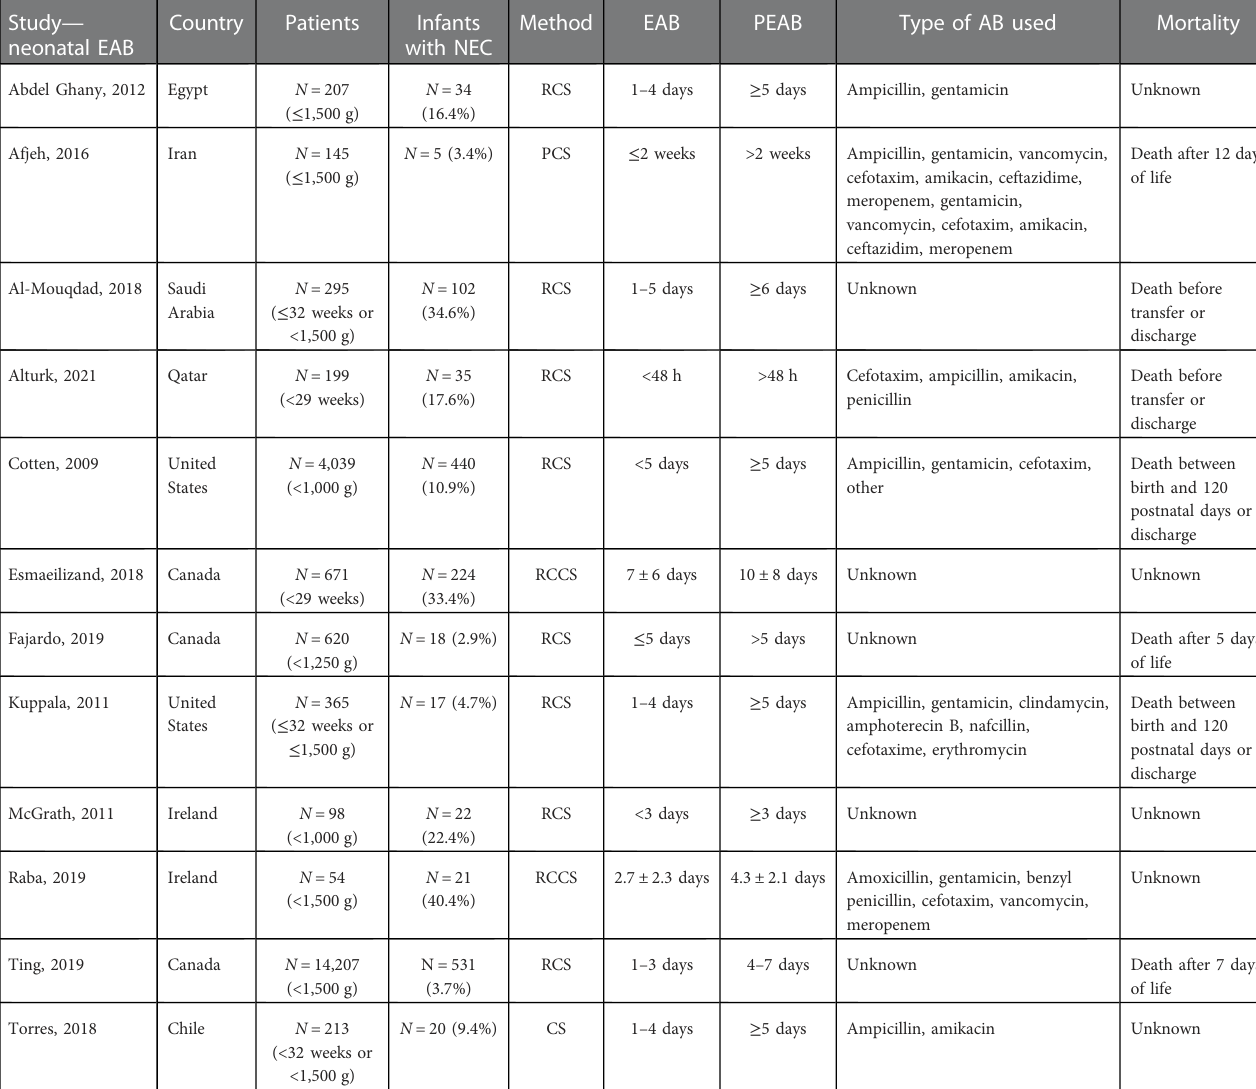
TABLE 3 Characteristics of studies on prolonged empirical antibiotics use in the